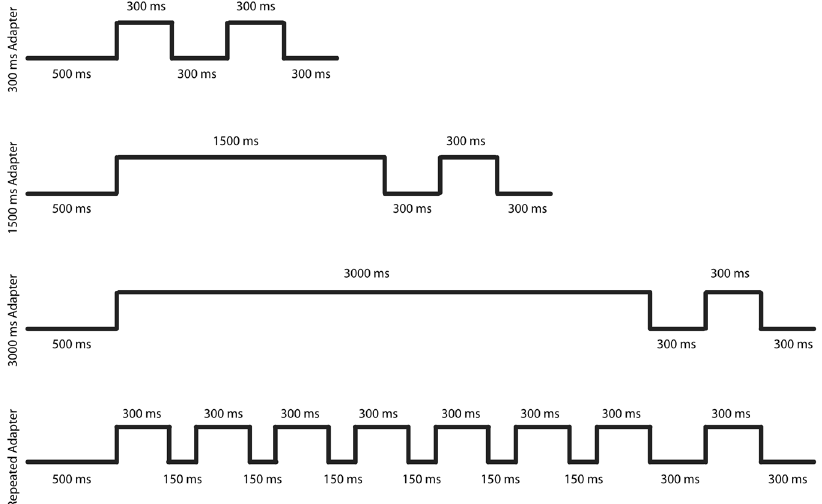
Figure 1. Adaptation protocols. The lower horizontal lines indicate periods during which only a fixation target was present, while the upper horizontal lines indicate stimulus presentations. Durations of the different periods are indicated below (for fixation target only periods) and above (for stimuli) the lines. The last 300 ms stimulus period correspond to the test stimulus presentation. Successful fixation during the entire trial resulted in a juice reward following the last fixation target-only